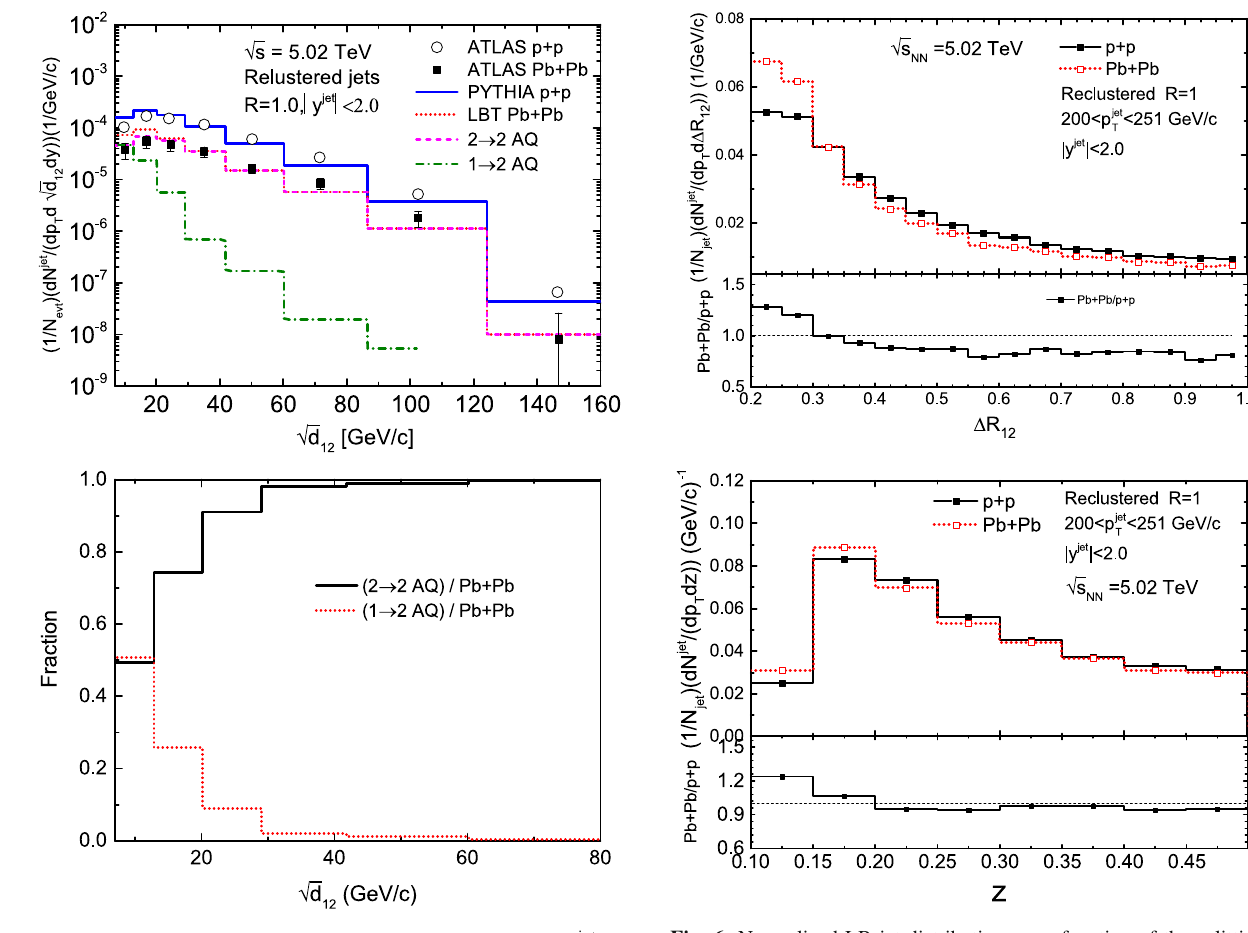
/ p jet in both T T √ s NN = 5 . 02 TeV (bottom